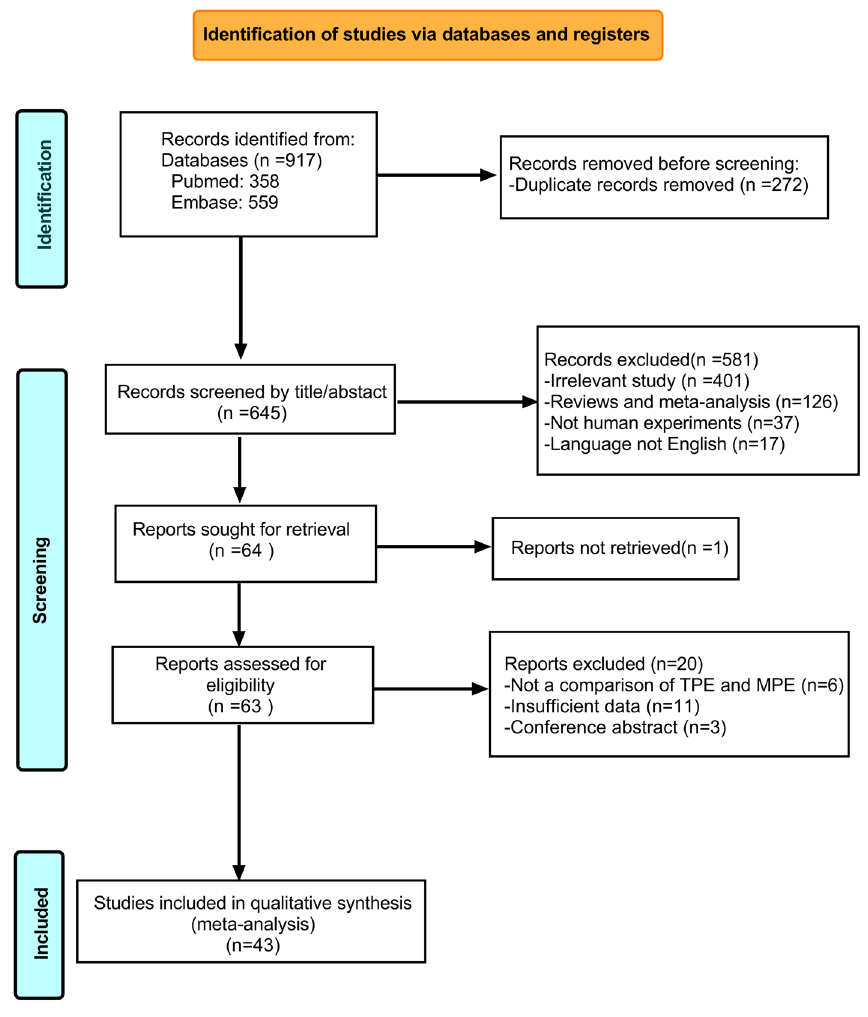
Figure 1. PRISMA flow chart of the selection of studies.